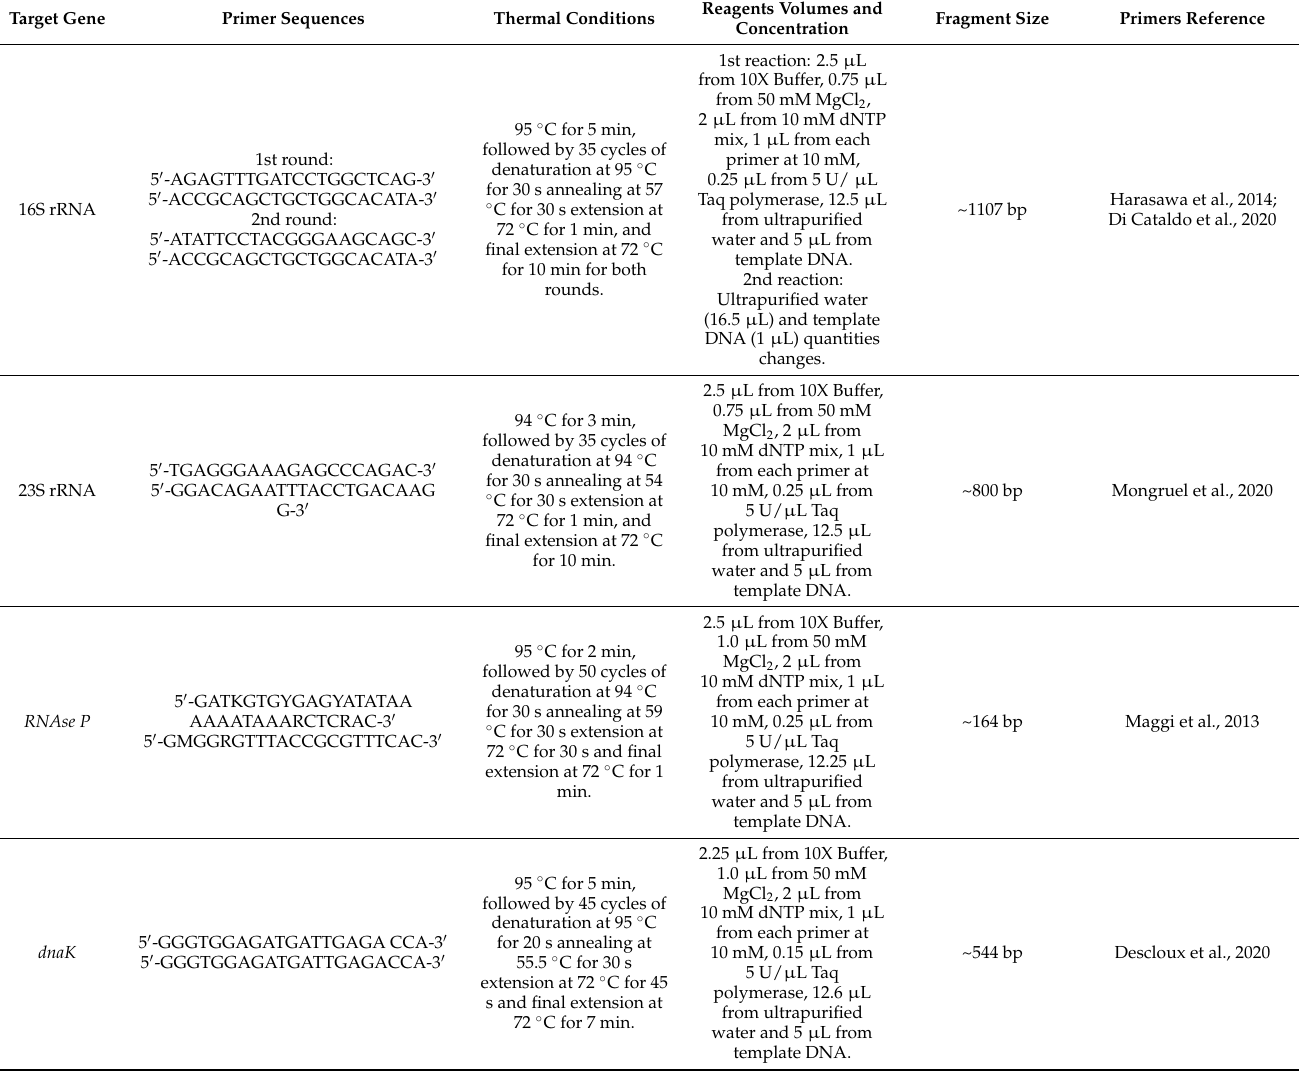
Table 1. Target genes, primers, thermal conditions, and reagent protocol used in the PCR assays for hemoplasmas based on the 16S rRNA, 23S rRNA, RNAse P , and dnaK